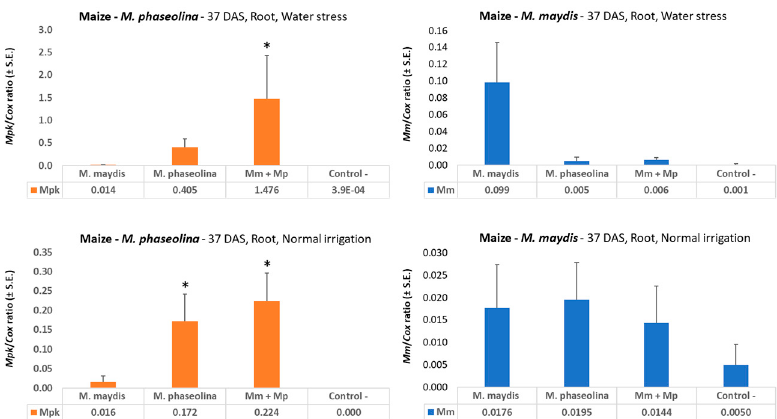
Figure 2. qPCR diagnosis of M. maydis and M. phaseolina in maize sprouts. A full-growth season pot experiment under field conditions was conducted in the spring and summer of 2019 with a late-wilt-susceptible maize genotype prelude. The quantitative real-time polymerase chain reaction (qPCR) was used to identify the ability of the pathogens, alone or in mixed inoculation, to infect and colonize maize root tissues 37 days after sowing (DAS). Half of the treatments received reduced irrigation (water stress, upper panel, see Table 1). The control is soil taken from a nearby field with minor levels of M. maydis or M. phaseolina infestation. The y-axis values are M. maydis relative DNA ( Mm ) or M. phaseolina relative DNA ( Mpk ) abundance normalized to the cytochrome c oxidase ( Cox ) DNA. Vertical upper bars represent the standard error of the mean of 10 replications (pots, each containing one plant). When existing, significance from the control is indicated as * = p < 0.05. Table 4. Maize average growth indices at 34 DAS 1 as a result of infection with M. maydis and M. phaseolina (the 2018 experiment).